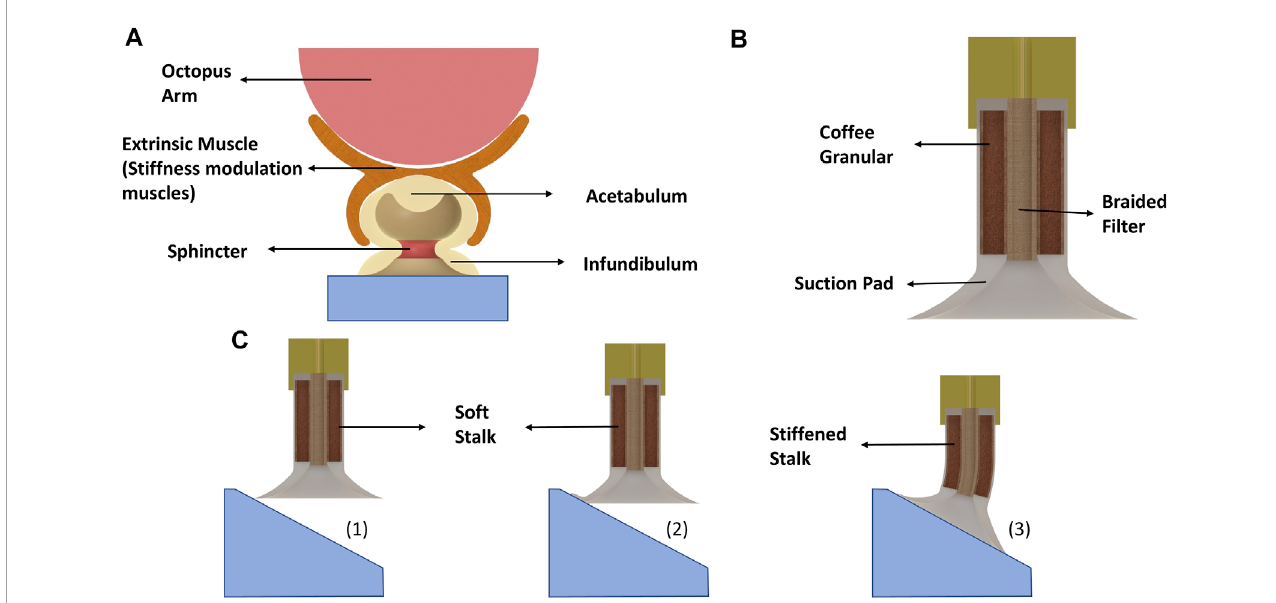
FIGURE 1 (A) Schematic illustration of octopus suction cup and the connection to its arm via extrinsic muscle. The extrinsic muscles enable the octopus suction cup to have rotary motion and also provide capability of stiffness modulation. (B) Conceptual design of the proposed suction cup. (C) The adaptation sequence of the suction cup to an angular surface.